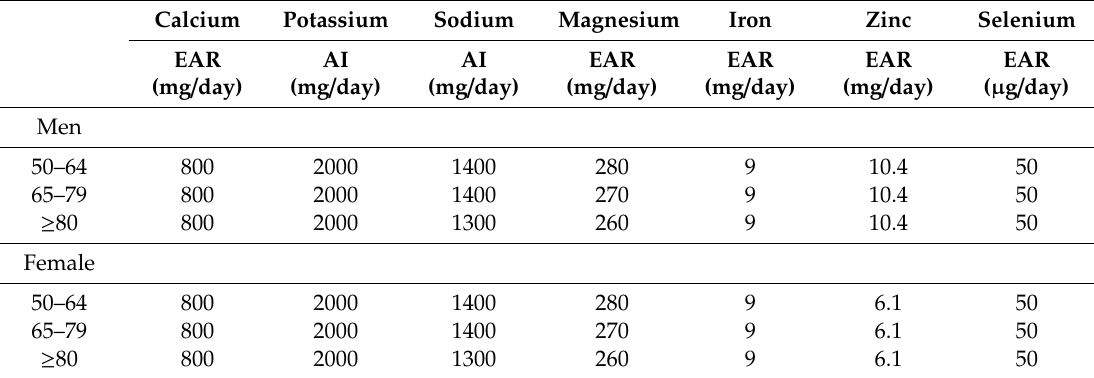
Table A2. EARs or AIs for selected minerals for Chinese elderly